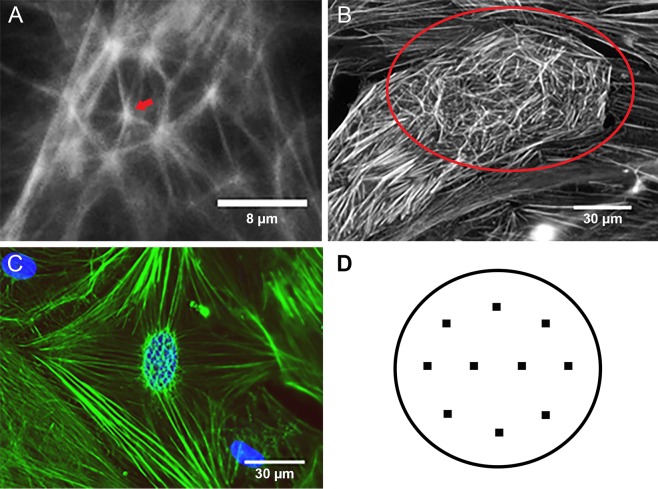
Morphology and evaluation of CLANs. (A) Representative image of a single CLAN in an NTM cell. The CLANs consist of distinct hubs (red arrow) and F-actin spokes, forming a dome-like structure. A minimum of three hubs creating at least one triangulated actin arrangement can be counted as a CLAN. (B) Representative image of multiple CLANs within a single cell (600× magnification). (C) Representative image of multiple CLANs at the perinuclear region (600× magnification). Blue: DAPI. (D) CLAN formation (percentage of CPCs) was evaluated in 10 representative areas (dots) of each coverslip.